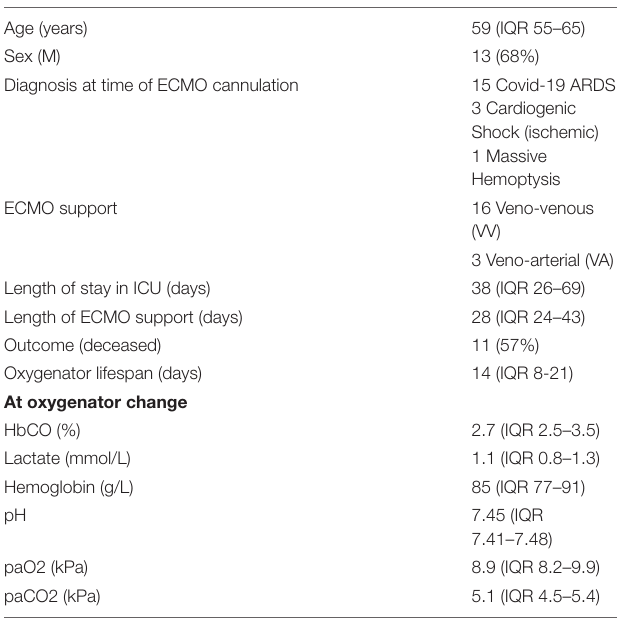
FIGURE 1 | Study flow chart.